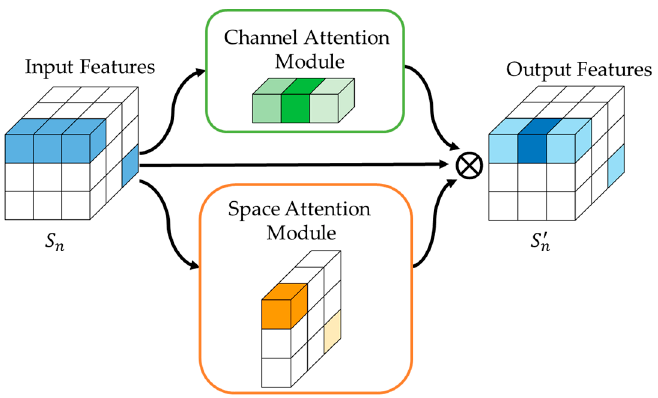
Figure 13. A tt ention network. Figure 13. Attention network.